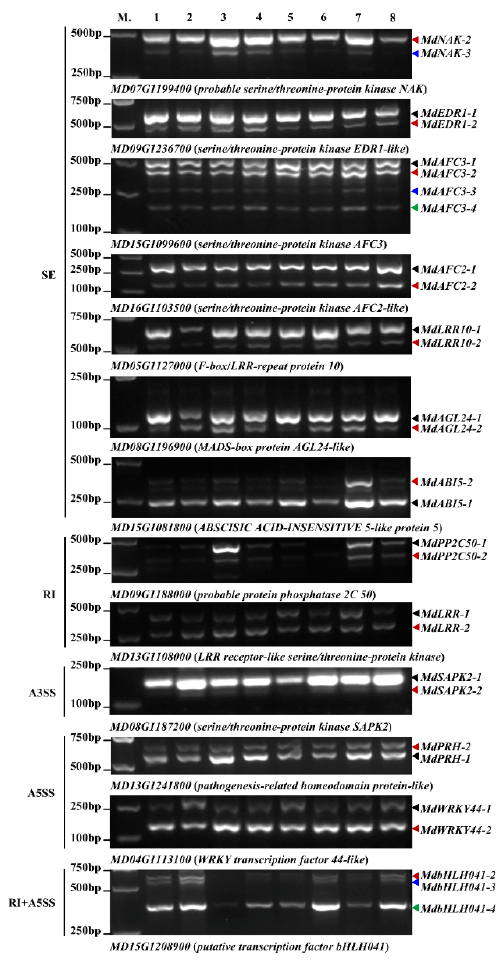
Figure 7. Expression patterns of pathogen-responsive AS events were validated by RT-PCR in apple leaves. Thirteen AS genes were analyzed to verify the reliability of our RNA-Seq data. Lane1 (M.) indicates the marker DL2000 and the ladder is noted on the left of agarose gel. Lane2~Lane9 (1~8) indicate the length and abundance of PCR products used to validate AS events under J36CK, J36HPI, J72CK, J72HPI, SD36CK, SD36HPI, SD72CK and SD72HPI conditions, respectively. The gene ID and annotation were given at the bottom of each panel.